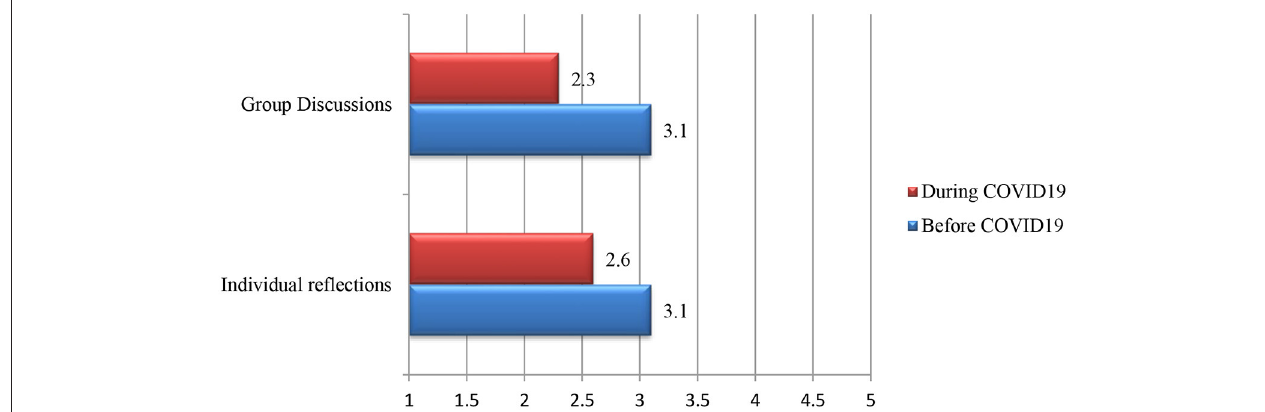
FIGURE 2 | Follow-up sessions (individual or group discussions) before and during